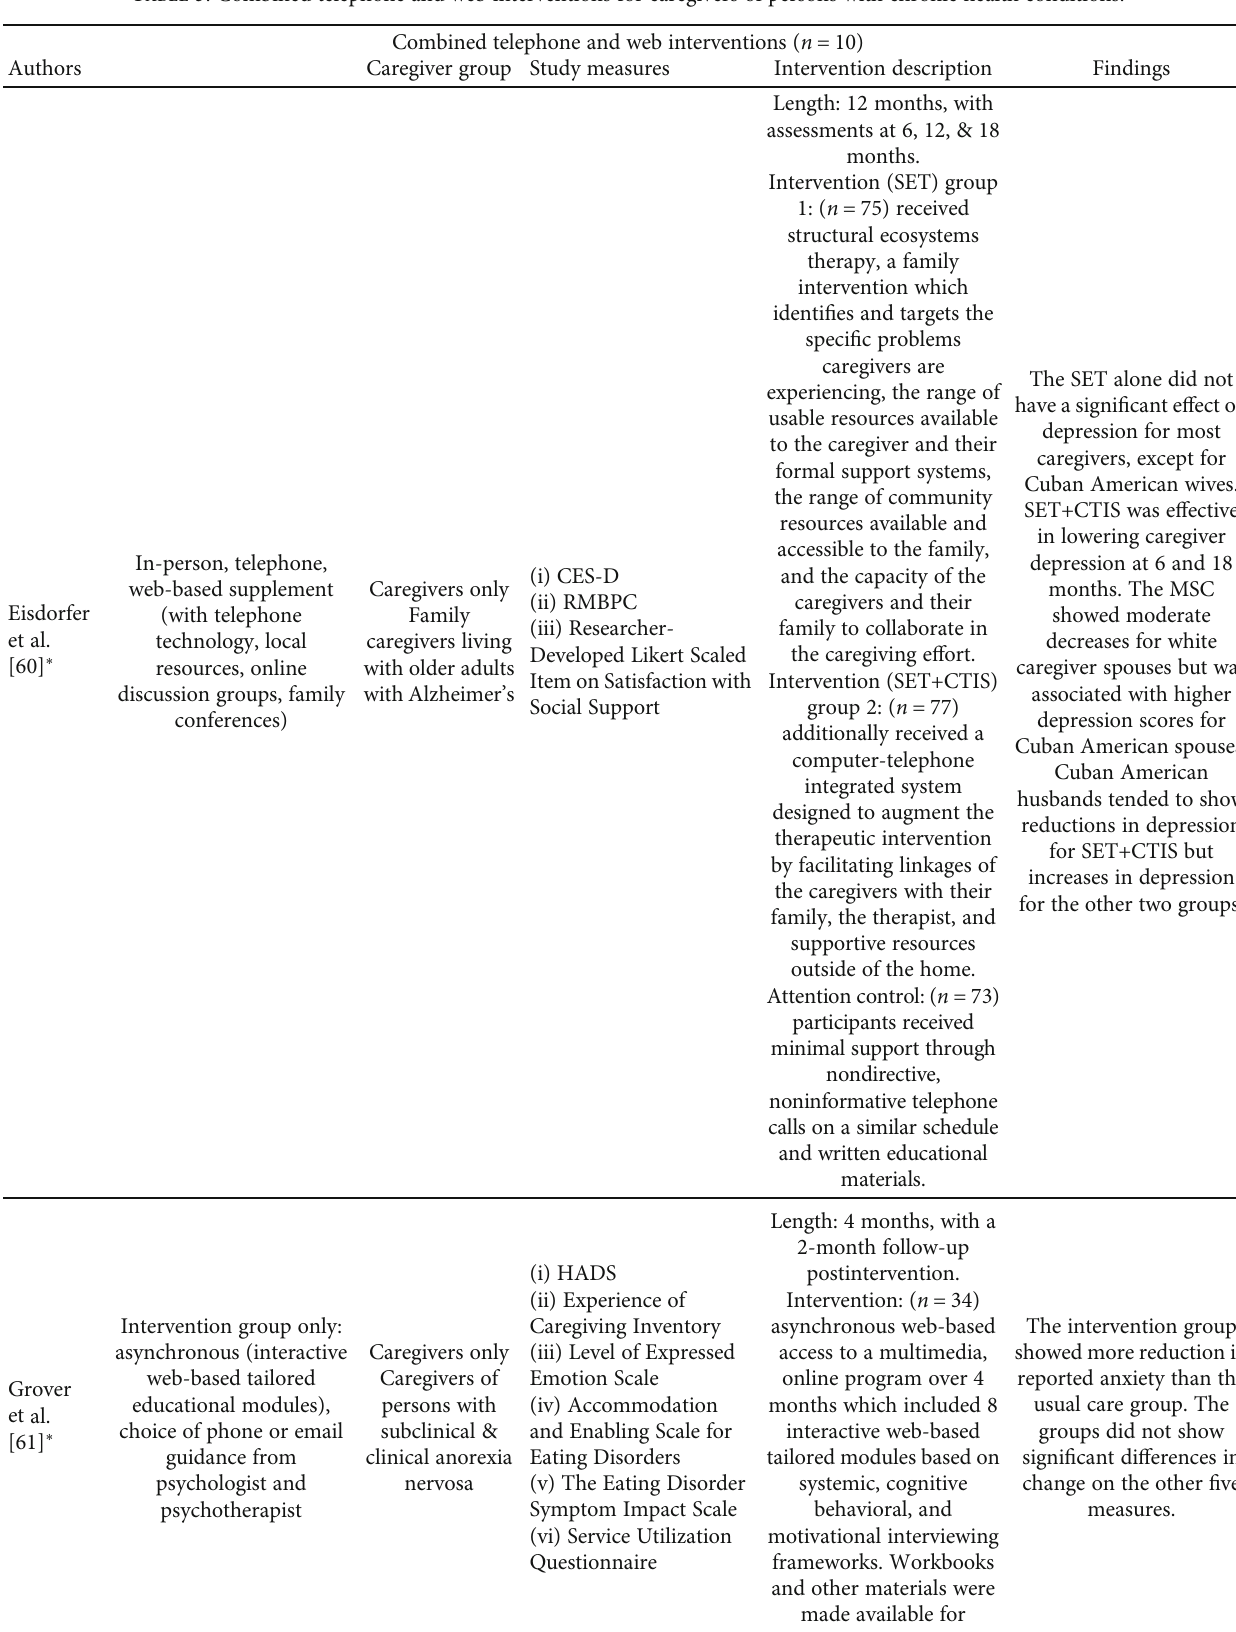
Table 5: Combined telephone and web interventions for caregivers of persons with chronic health